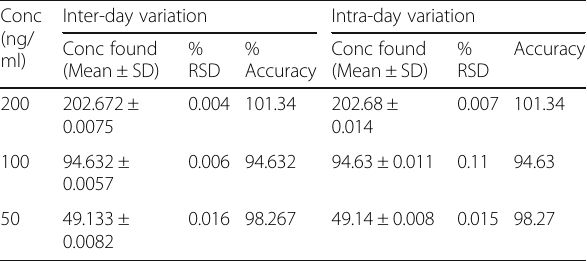
Table 7 Effect of variation in the parameters on the retention